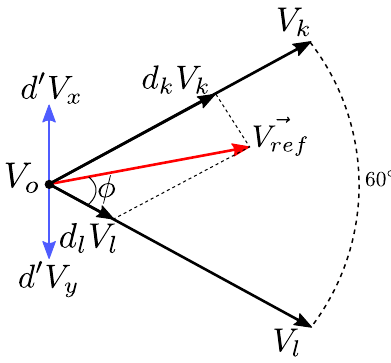
Figure 16. Modulation by modified vector